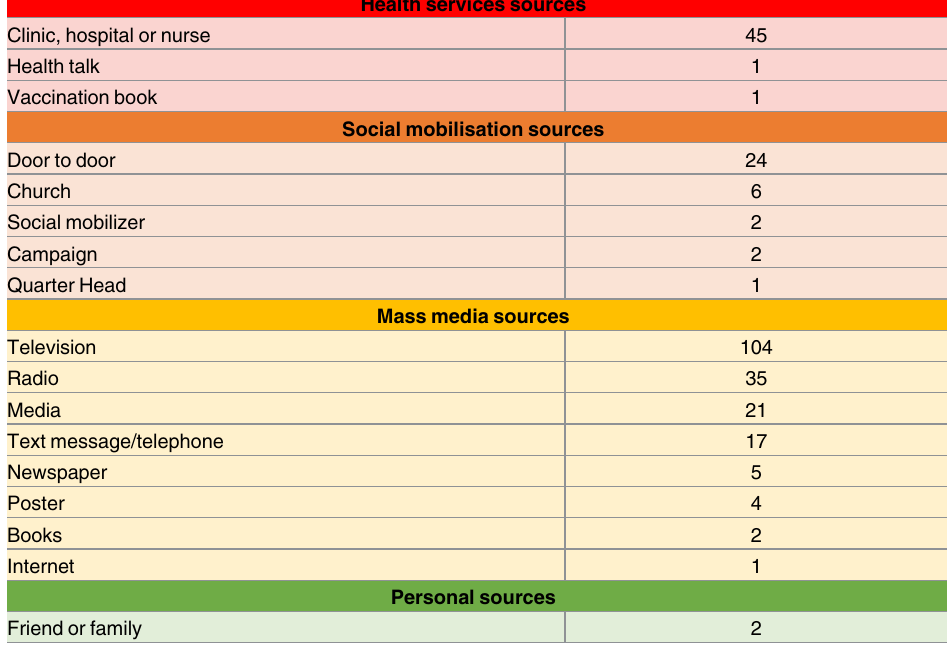
Table 2. Preferredsource of information as mentioned by parents during interviews and the